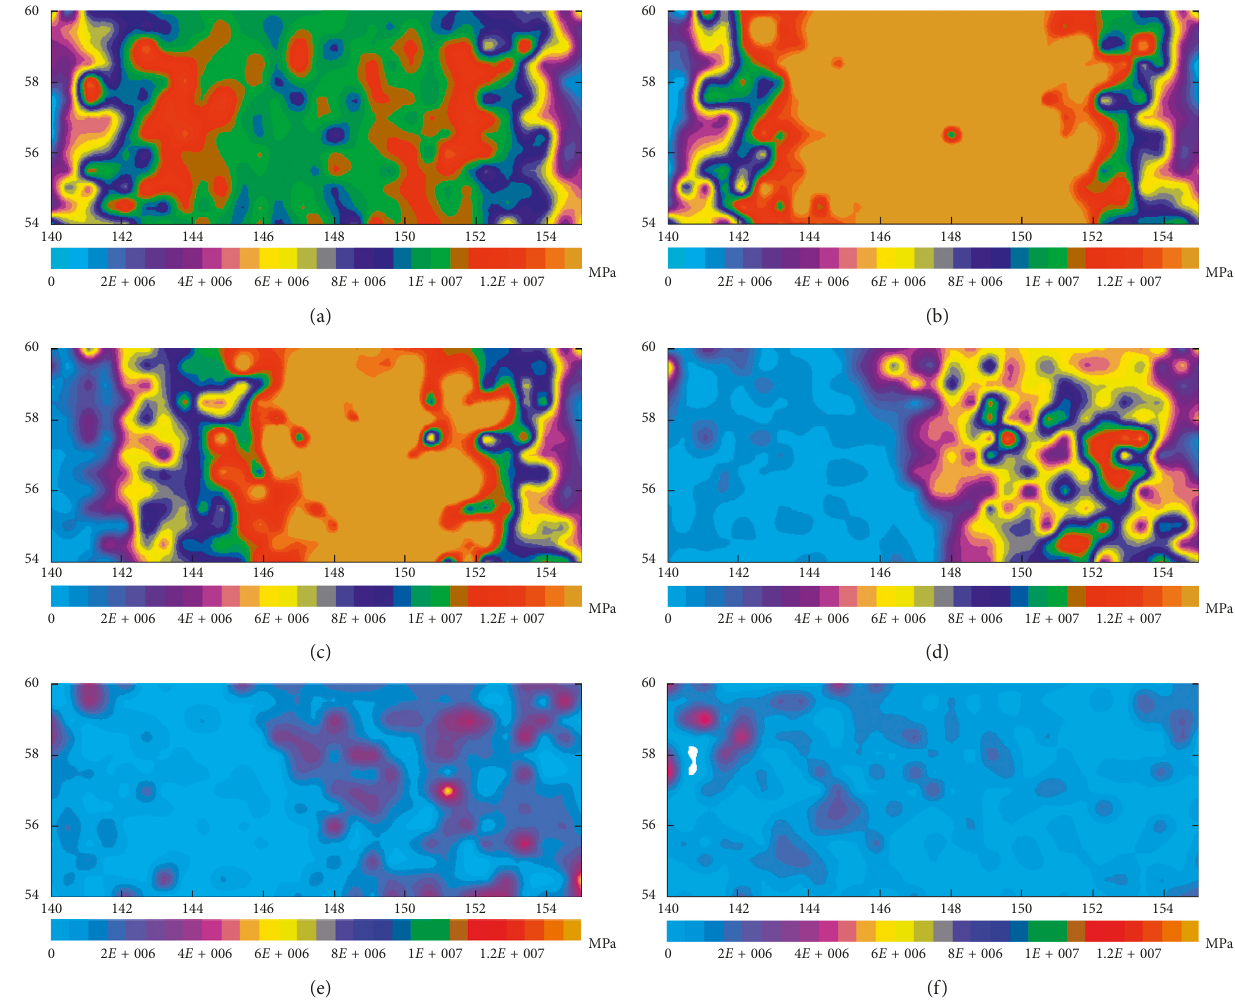
Figure 10: Evolution of vertical stress in Pillar B. (a) After excavation of three rooms in #4 seam. Panel in #6 seam advancing by (b) 50 m, (c) 80m, (d) 90m, (e) 100m, and (f)